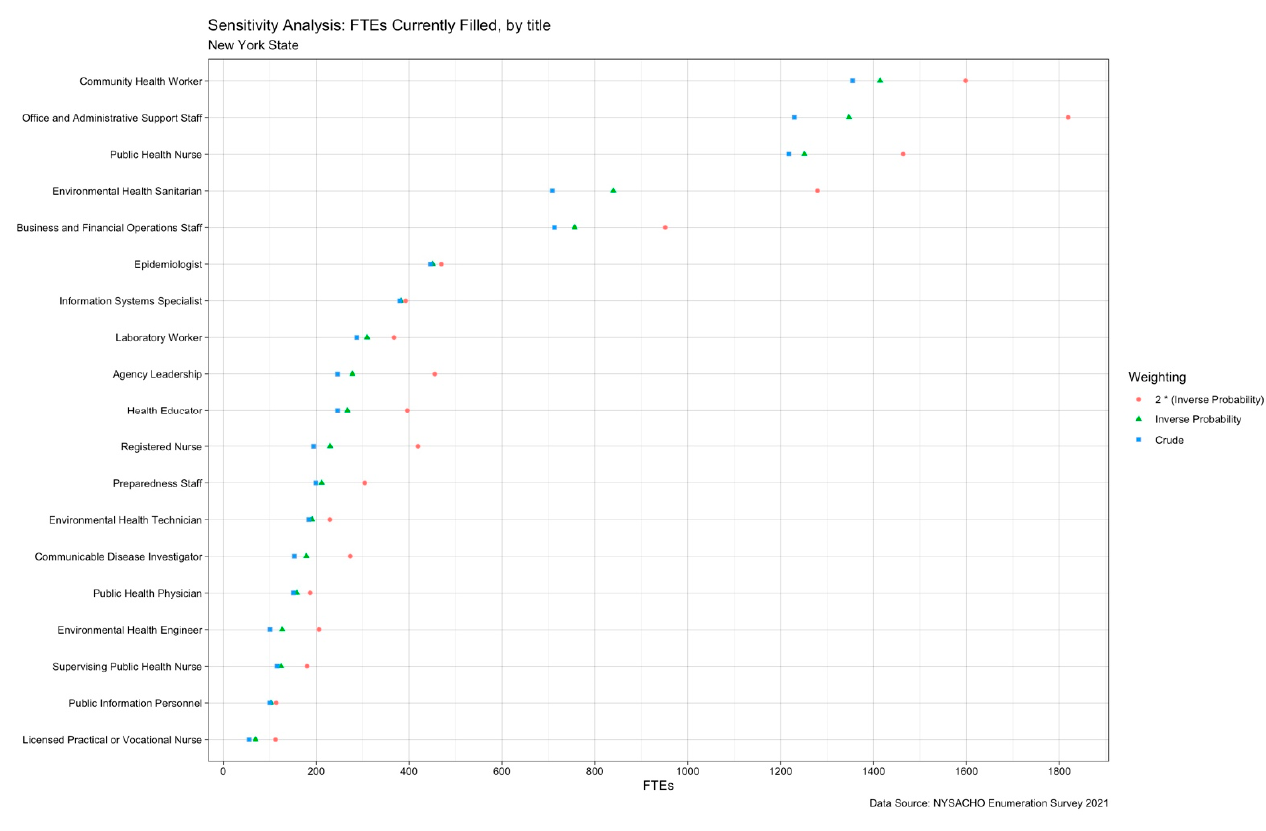
Figure A2. Sensitivity Analysis for Figure 1.